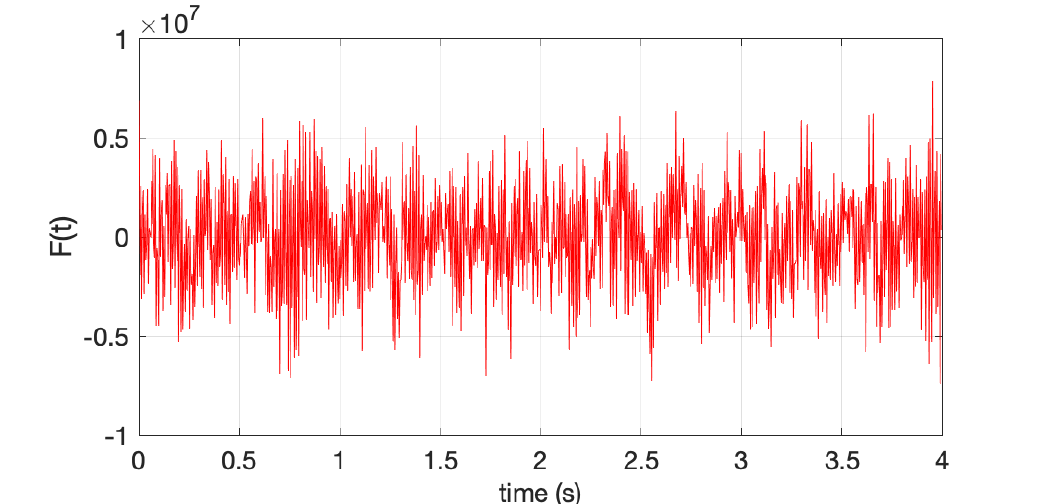
Figure 9. Loading involving a larger frequency